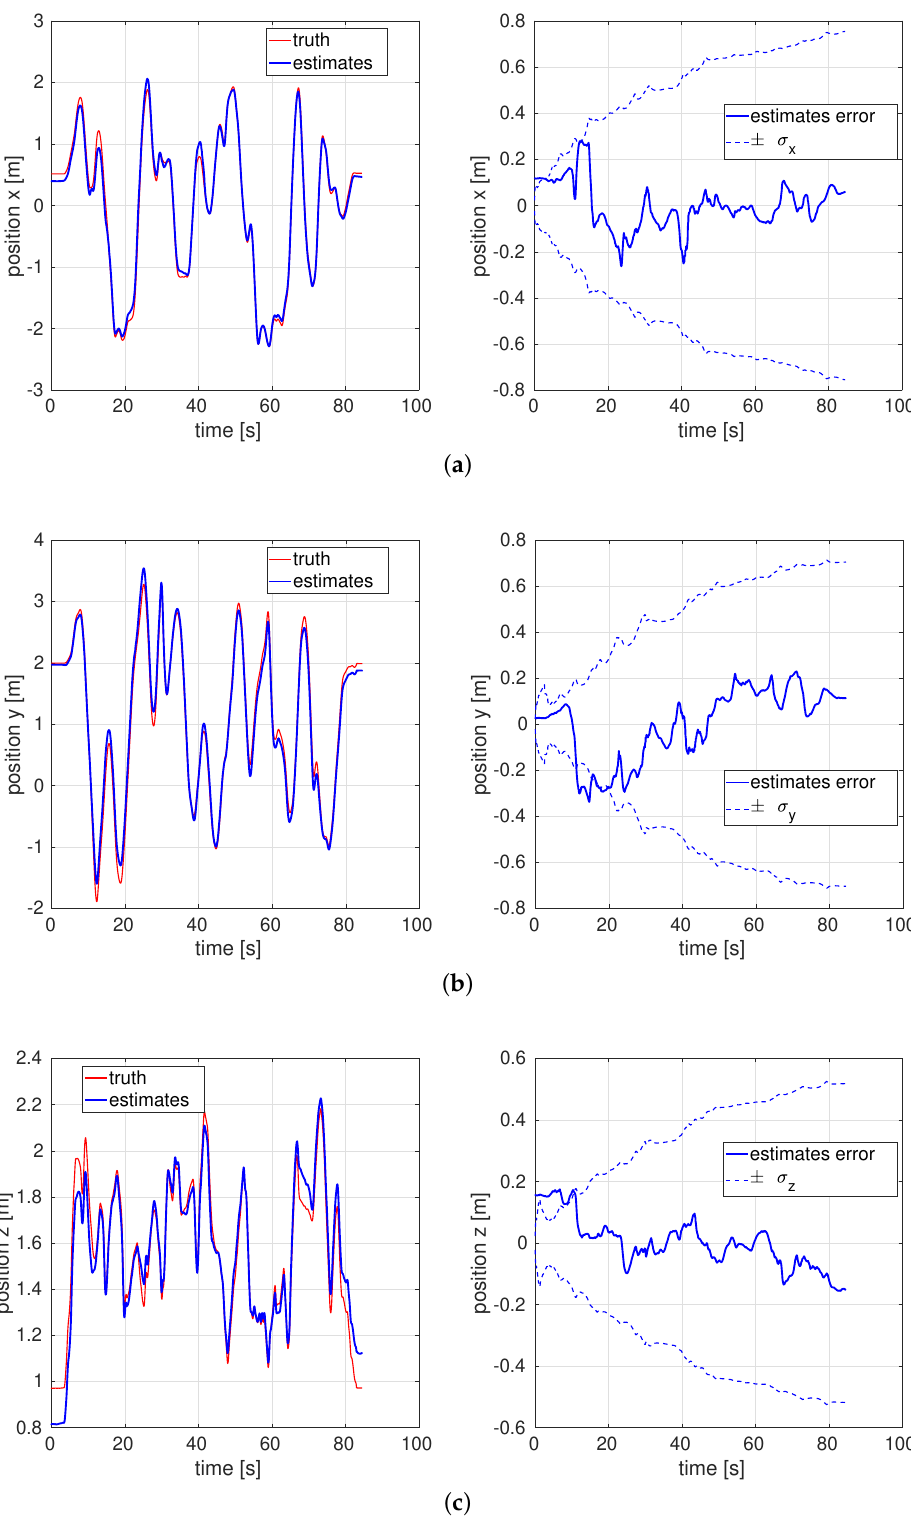
Figure 10. Position and estimation error of the EuRoC V1 medium dataset by the latency compensated VIO. ( a ) Position x , ( b ) Position y , ( c ) Position z